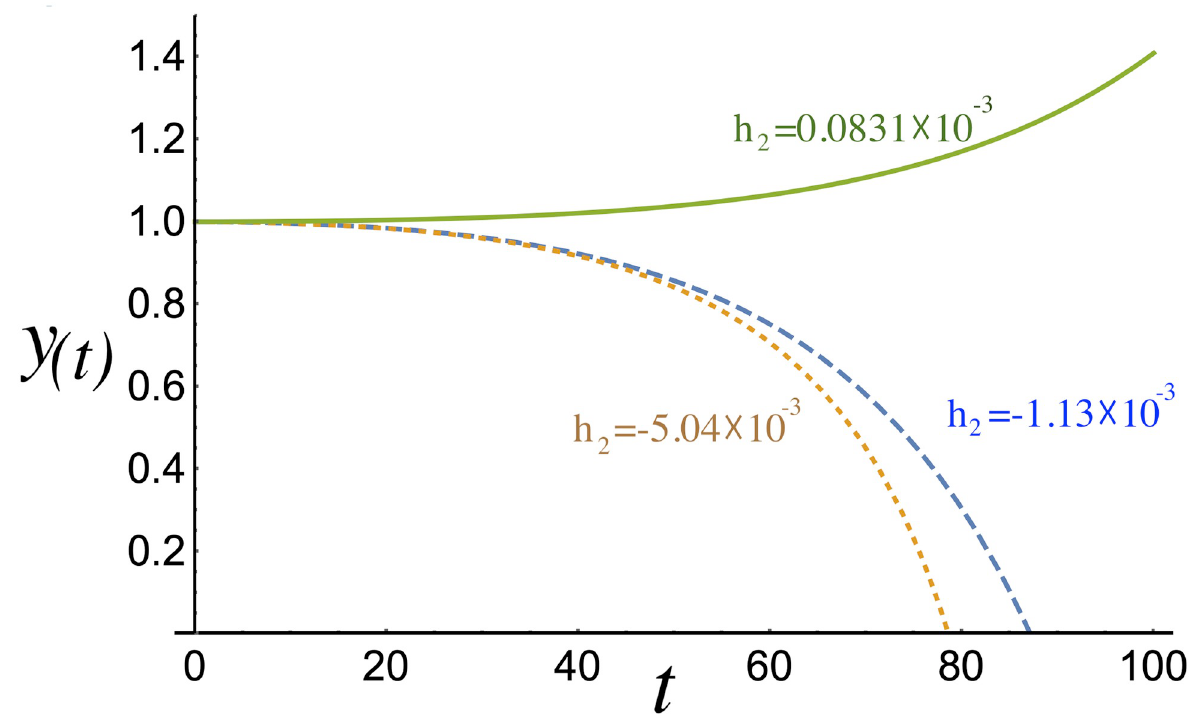
Fig 5. Comparison of the evolution of y ( t ) for different employee income concavities. The mode of W ( x , t ) is y ( t ) and, if h 2 < 0, over time it tends to zero. Conversely, if h 2 > 0, y ( t ) diverges from zero. The dotted, dashed, and solid lines represent the evolution of y ( t ) corresponding to c 1 ( x ), c 2 ( x ), and c 3 ( x ), respectively, for h 2 >